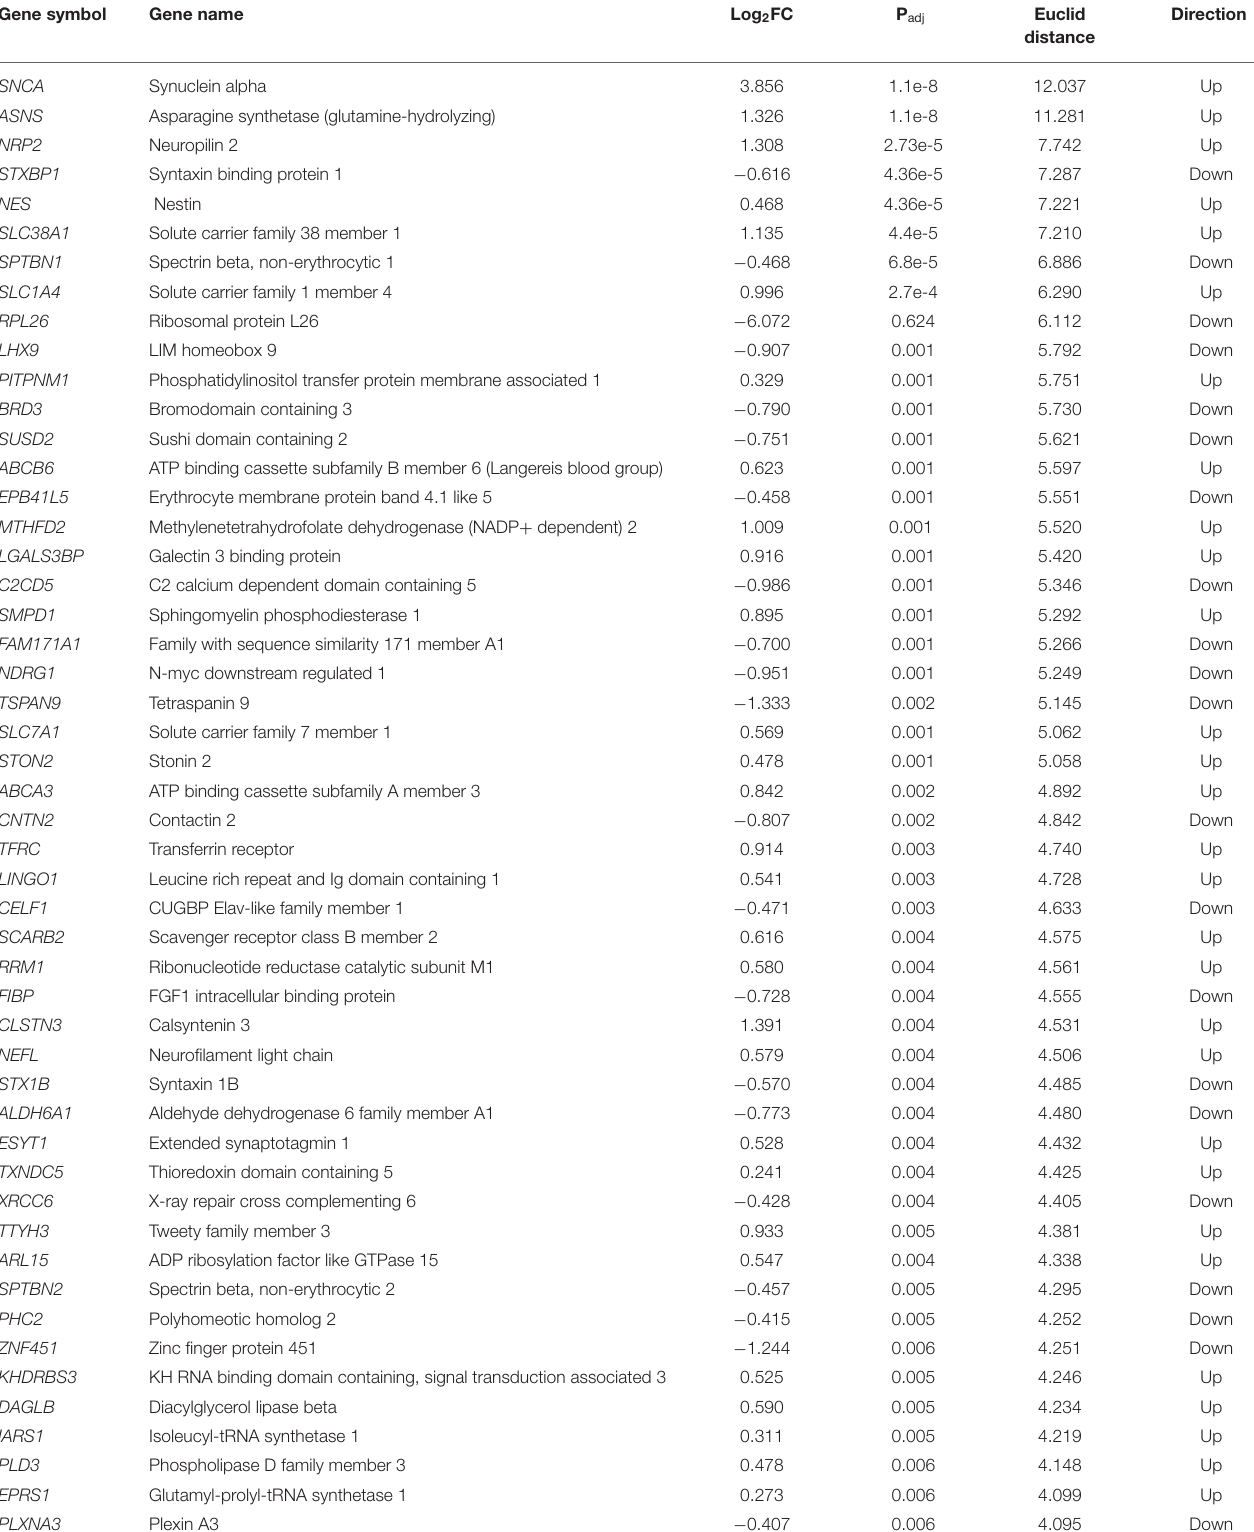
TABLE 2 | Top 50 differentially regulated proteins between alpha-synuclein-overexpressing and GFP-expressing cells, sorted by Euclidian distance. Gene